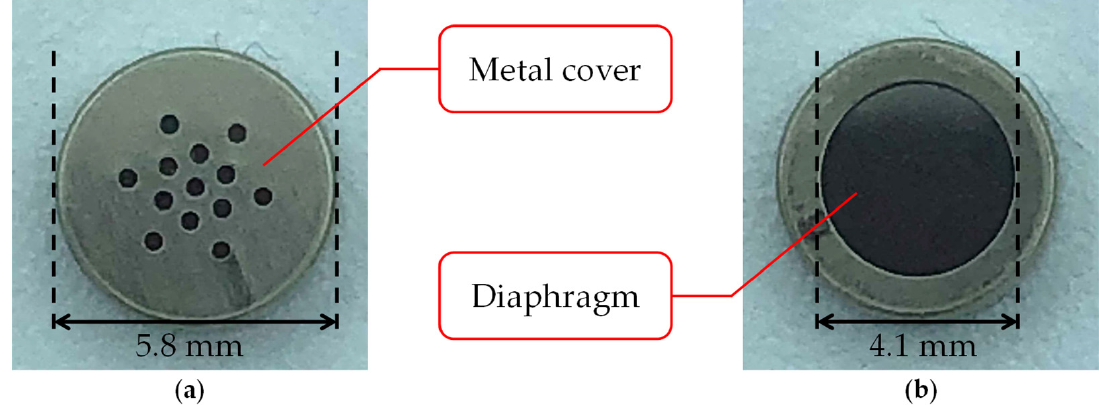
Figure 3. Electret condenser microphone (ECM): ( a ) before exposure; ( b ) after exposure.